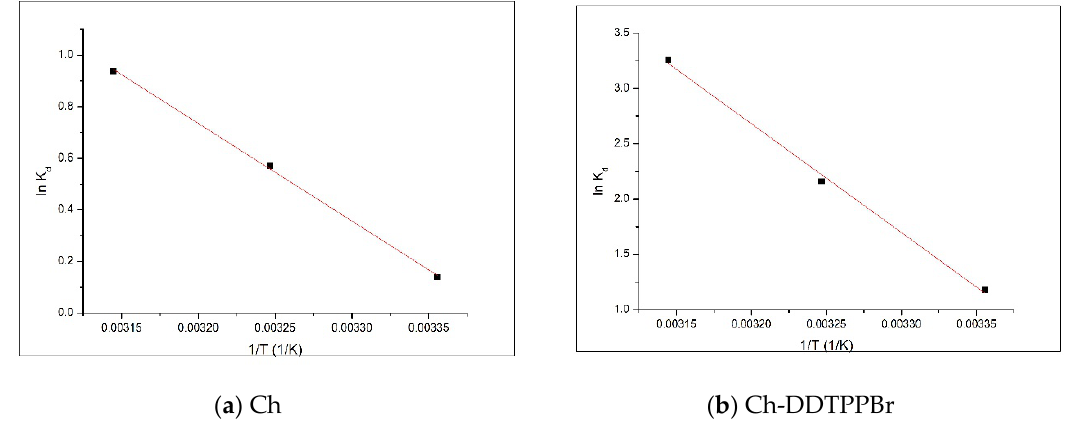
Figure 8. Van’t Hoff plots for the adsorption of Ag (I) onto ( a ) Ch and ( b ) Ch-DDTPPBr. Figure 8. Van’t Ho ff plots for the adsorption of Ag (I) onto ( a ) Ch and ( b ) Ch-DDTPPBr. Table 2. Thermodynamic parameters for adsorption of Ag(I) on the adsorbent materials. ∆ H ◦ Materials